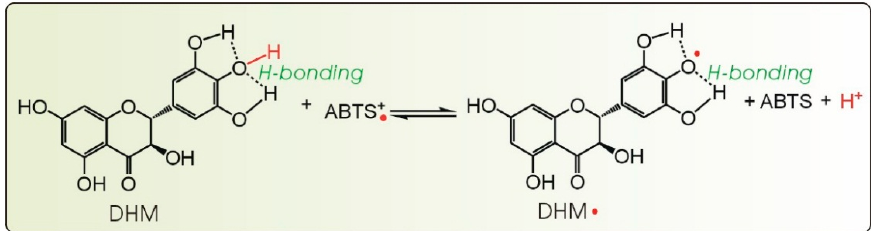
Figure 5. The one-electron transfer from ABTS to ABTS + • [30]. Figure 6. The proposed reaction of DHM with the ABTS + • radical cation (initial stage).